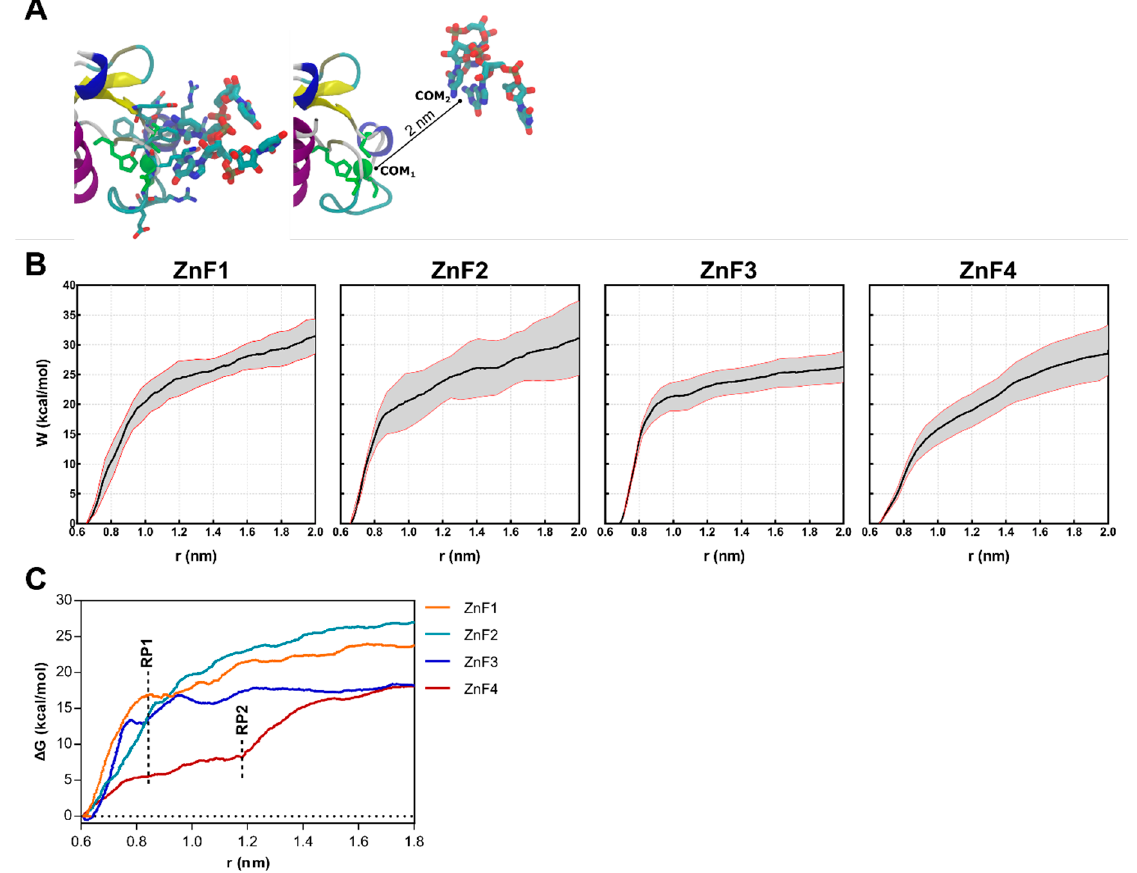
Figure 6. Results obtained from the sMD procedure on each of MBNL1 ′ s ZnFs-RNA systems. ( A ) Representative snapshots of the initial (left) and final (right) coordinates of the sMD pulling process. The CCCH motif of each ZnF is colored green. ( B ) Cumulative work profiles for each ZnF vs. distance from the COM (r) between ZnF and RNA ligand. Black and red lines represent the mean and the 95% confidence interval. ( C ) Potential of Mean Force (PMF) for each ZnF extracted from the mean work profile. RP1 and RP2 correspond to the observed rupture points.